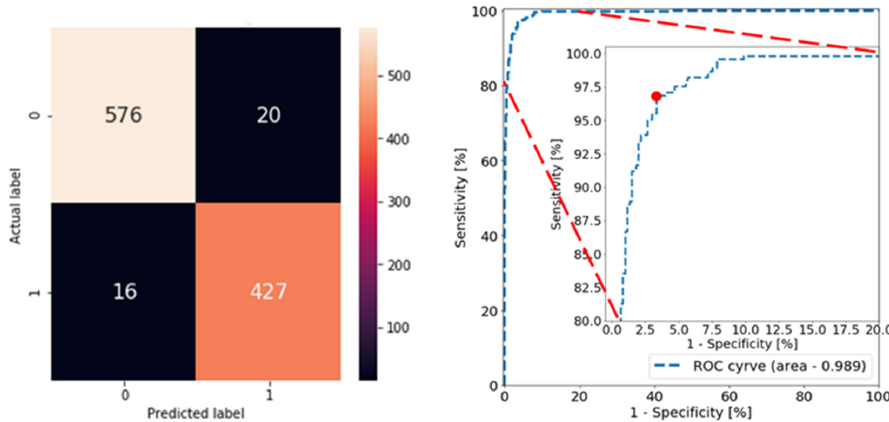
Figure 5. The confusion matrix and ROC curve for the best model (Xception backbone with geometric distortion, brightness, and contrast adjustment augmentation during training) evaluated over test data.